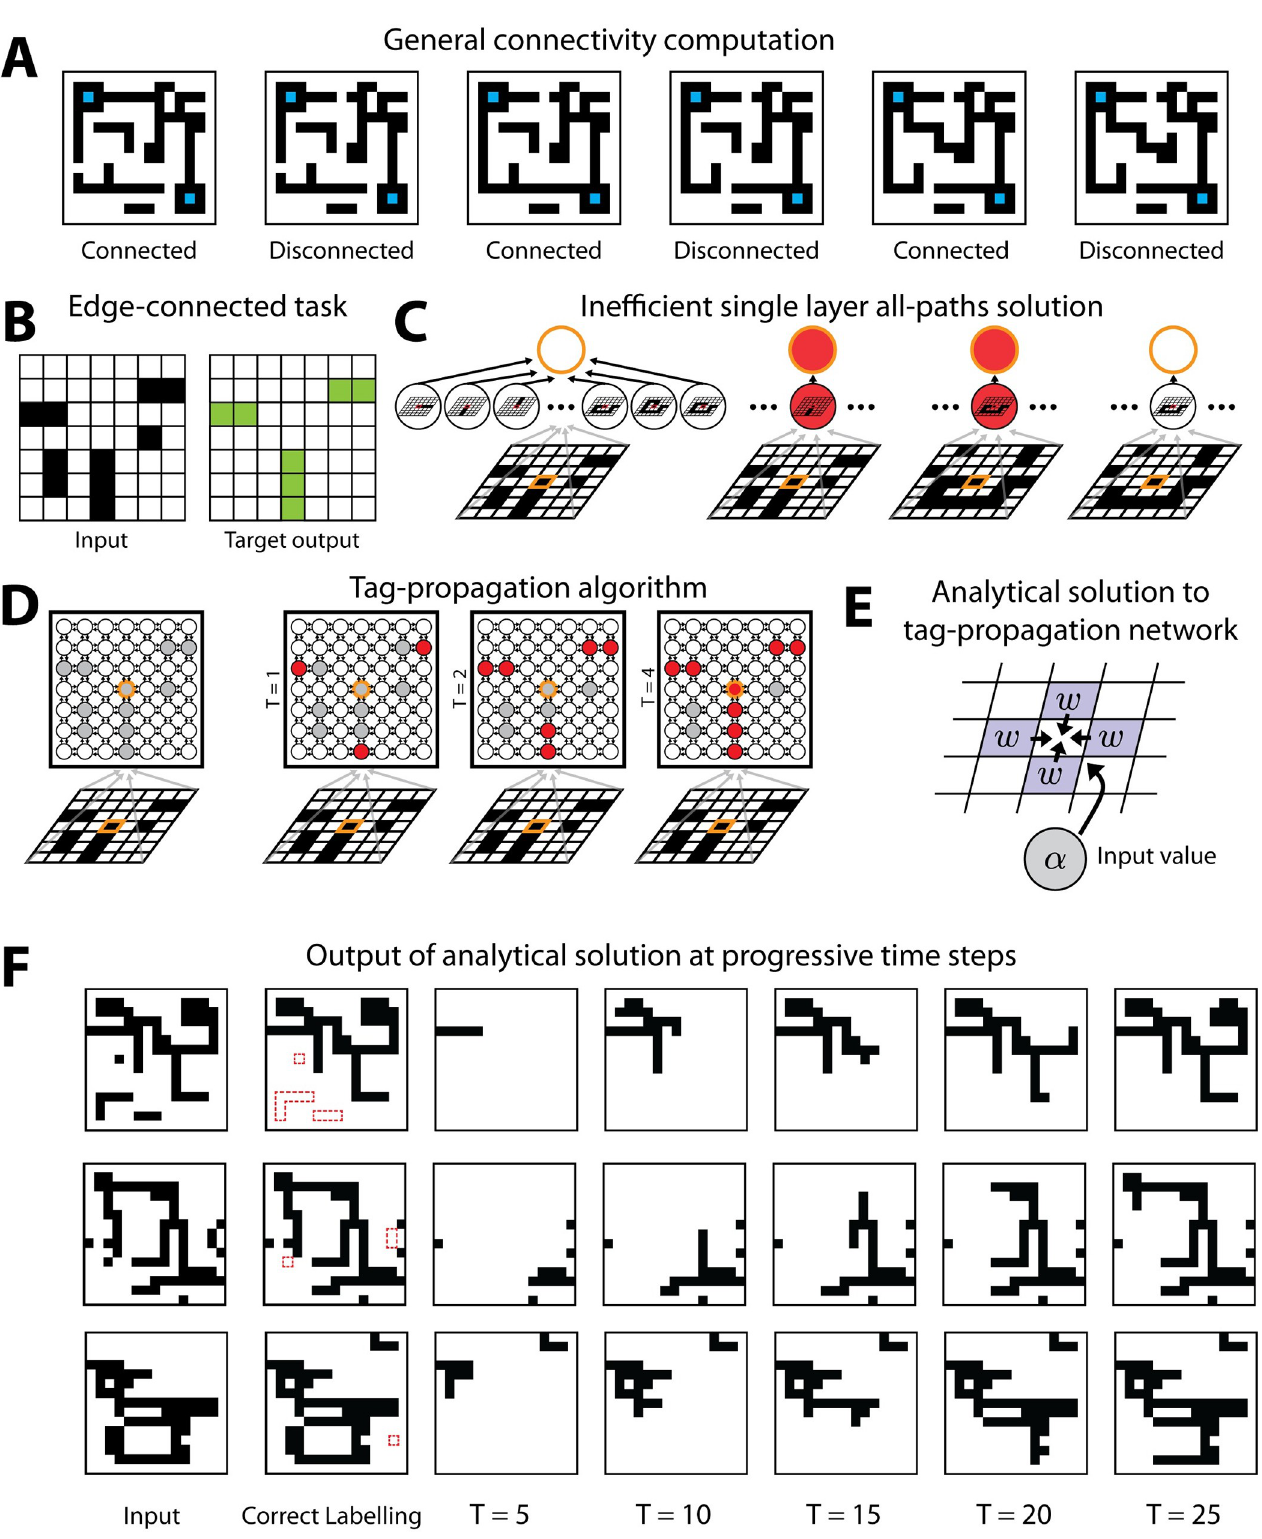
Fig 1. Edge-connected pixel task. (A) Illustration of the general connectivity task and its global nature. (B) Example of an input image and correct labelling for that image in the edge-connected pixel task. (C) Implementation of the single-hidden layer architecture for detecting whether the center pixel is connected